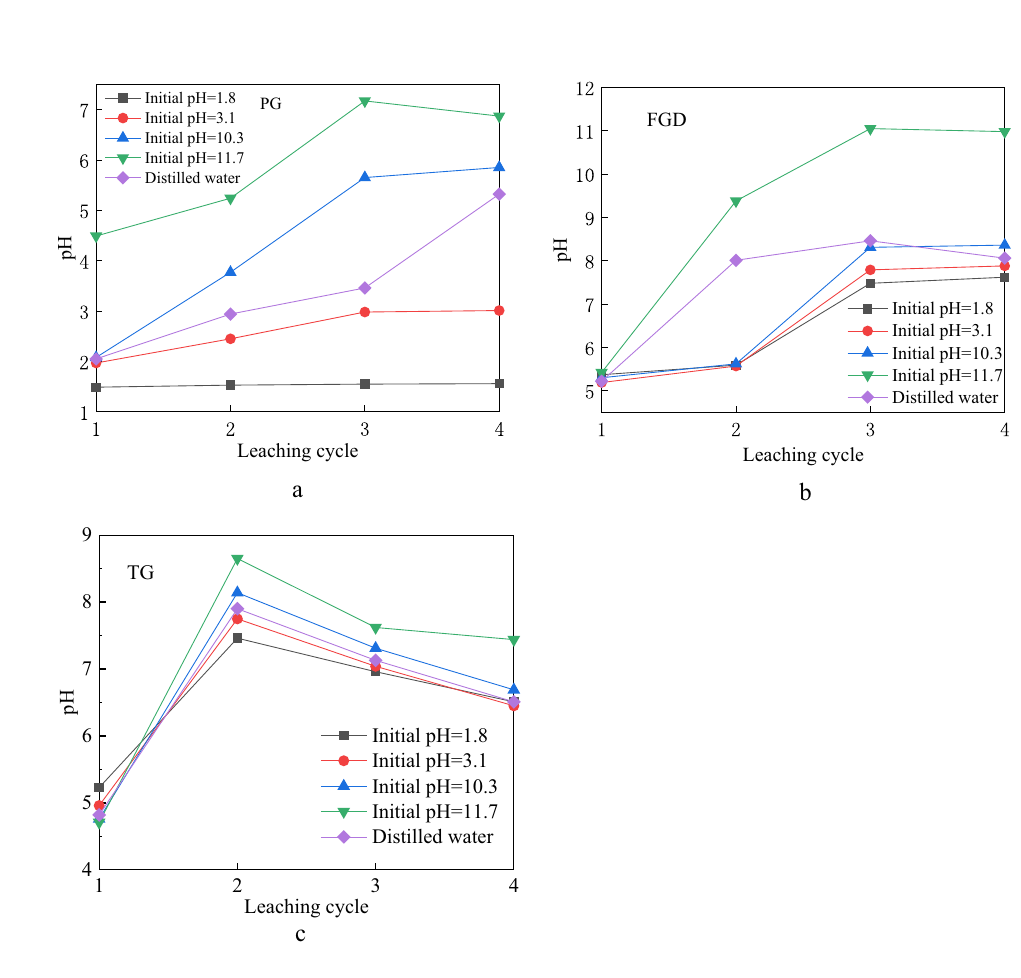
Fig. 3 Time evolution of the leachate pH during sequential batch